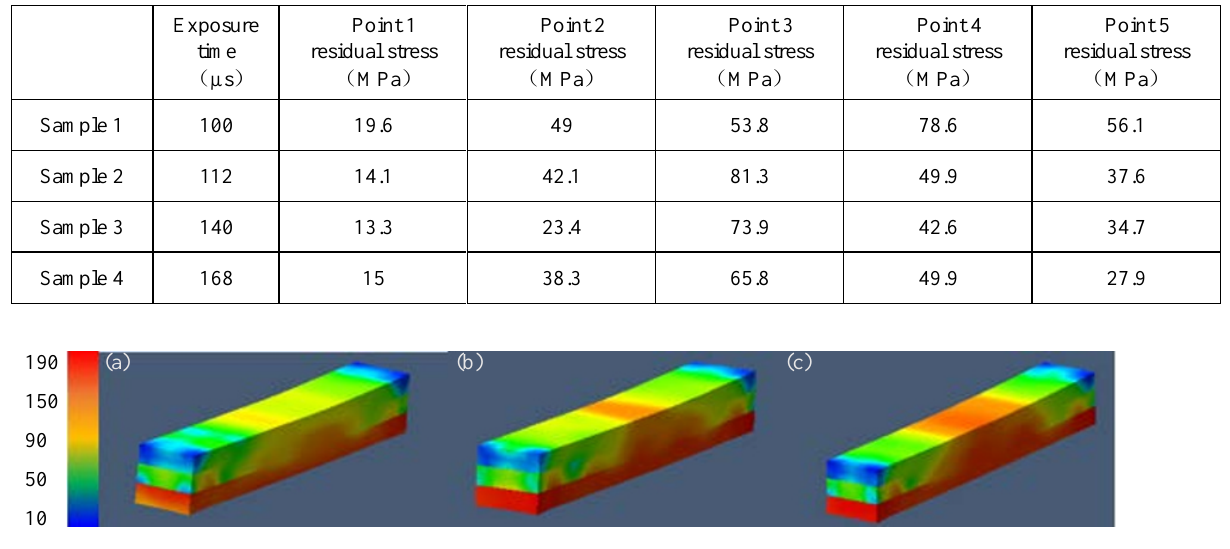
Fig. 6. The residual stress nephogram of the sample (MPa): (a) 200W; (b)300W; (c)400W